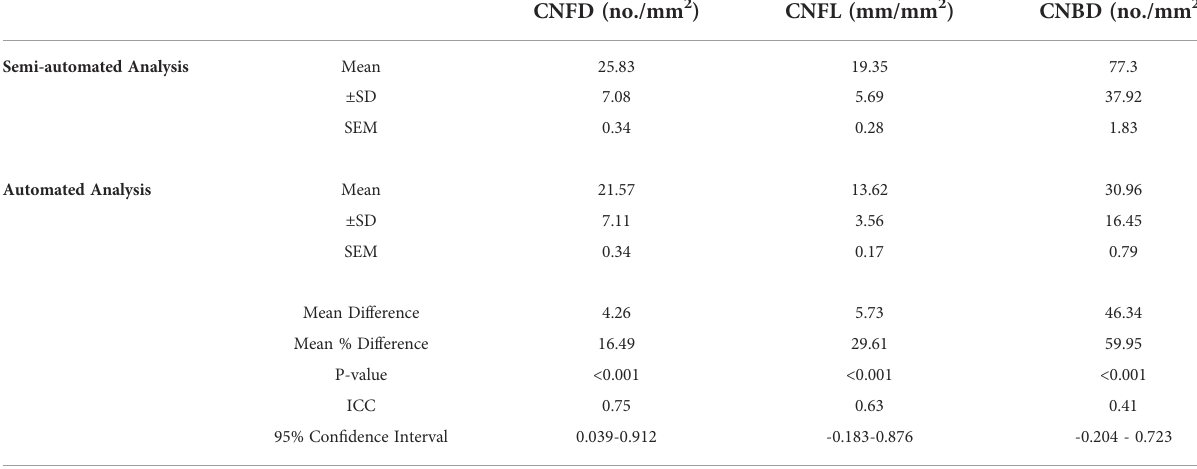
TABLE 3 Comparison of automated and semi-automated